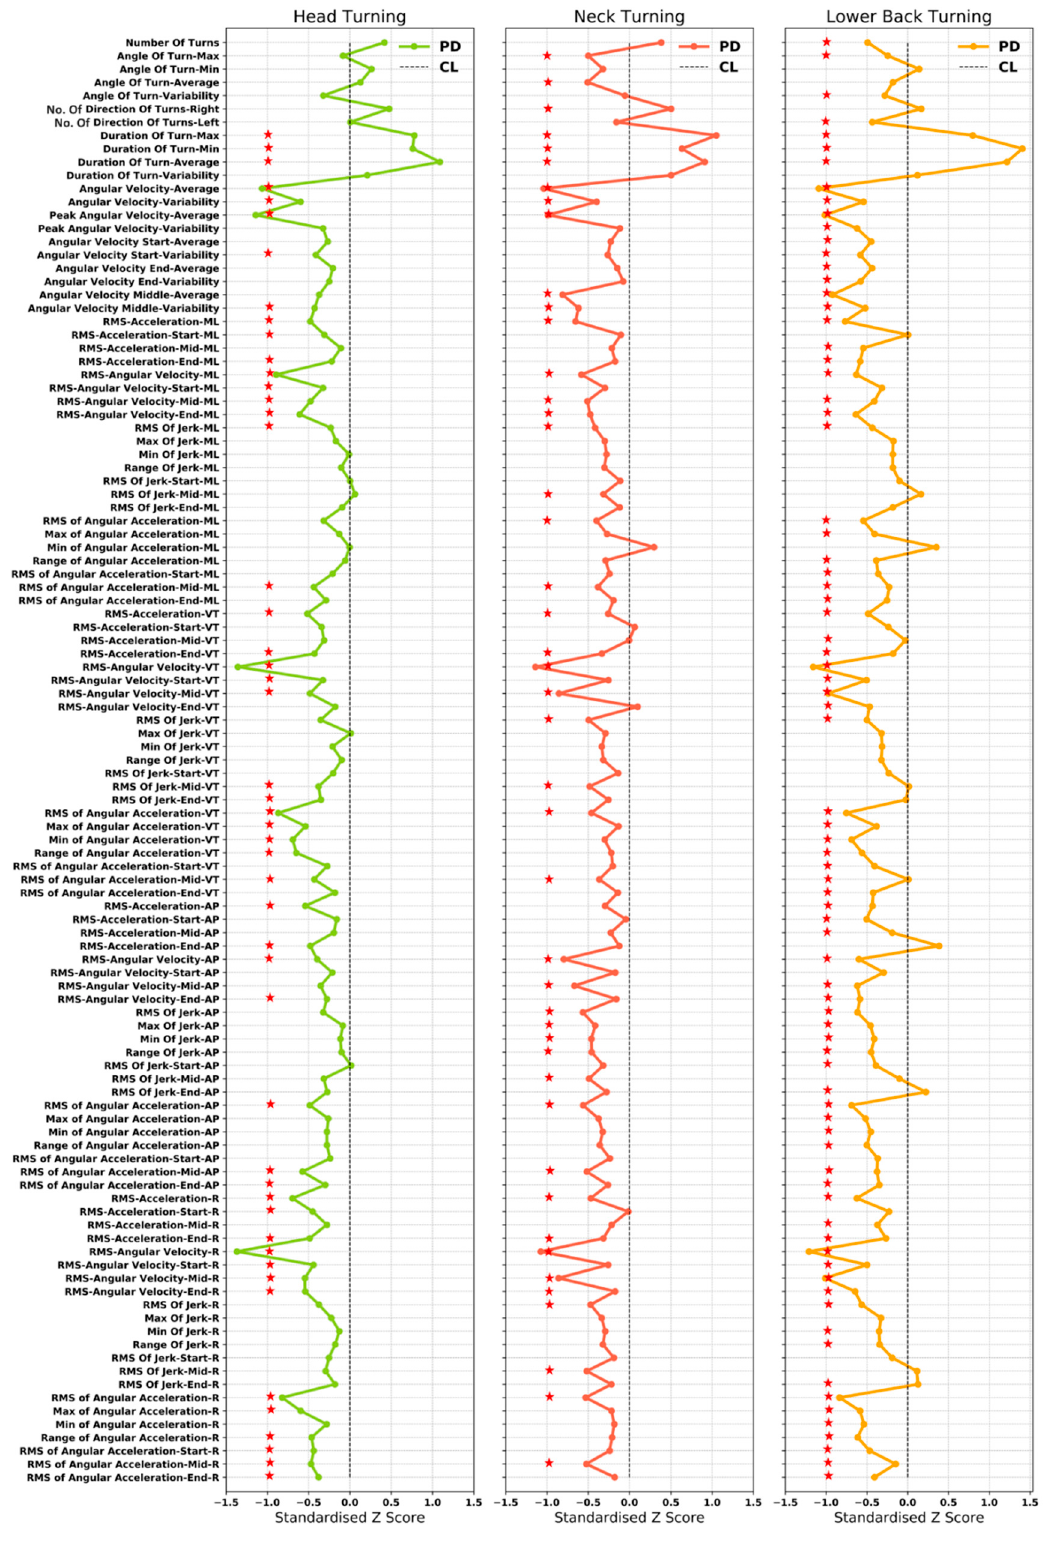
Figure 3. Group differences between turning characteristics extracted from the upper body for PD Figure 3. Group di ff erences between turning characteristics extracted from the upper body for PD and and CL (red star indicates significant group differences p < 0.05). CL (red star indicates significant group di ff erences p <